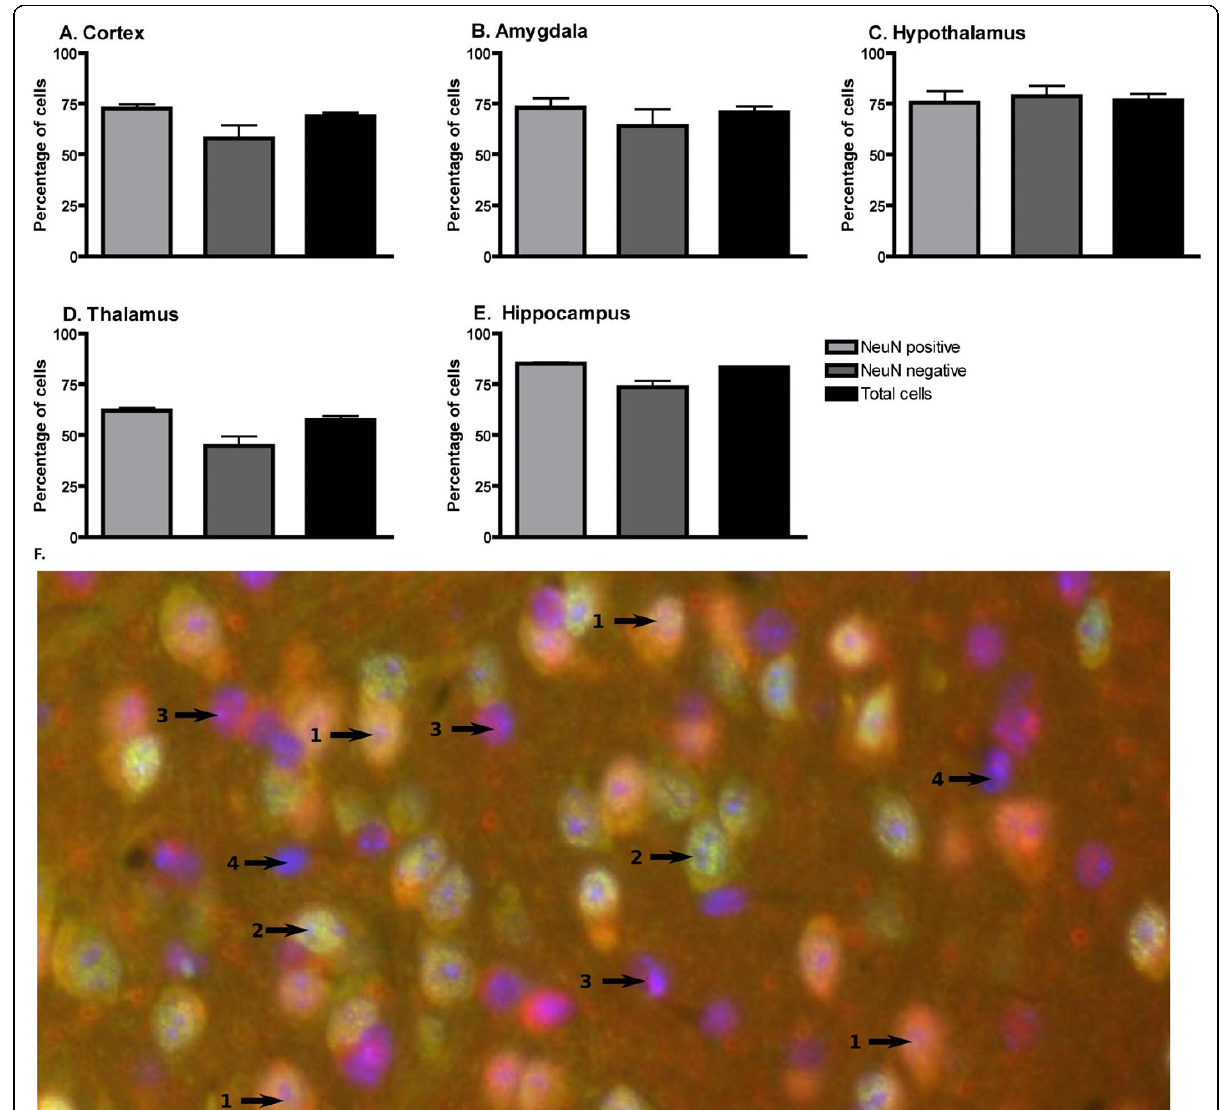
Figure 5 The TMEM18 protein distribution in different cells in the mouse brain . Averaged percentages of different cell types positive for TMEM18 in five regions of the mouse brain: A . Cortex, B . Amygdala C . Hypothalamus D . Thalamus and E . Hippocampus. Sections were stained with DAPI (blue) as a cellular marker, NeuN antibody (green) for neurons and TMEM18 antibody (red). F . cell types in the hypothalamus are marked with arrows and numbered as follows: 1 . TMEM18-positive neurons, 2 . TMEM18-negative neurons, 3 . TMEM18-positive non-neurons and 4 . TMEM18-negative